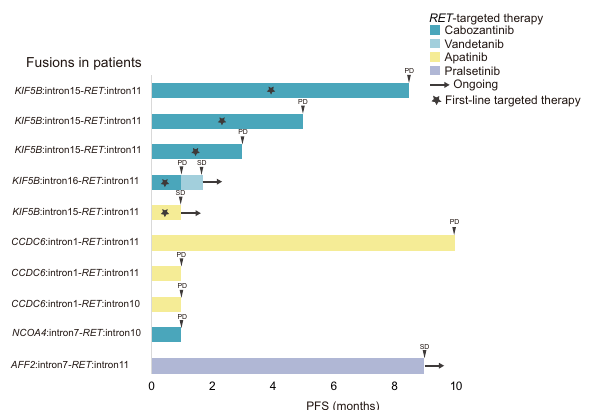
Fig. 4 Progression Free Survival (PFS) of patients carrying RET fusions. Swimmer plot showing treatment drugs and durations (months). Patients with different fusions are